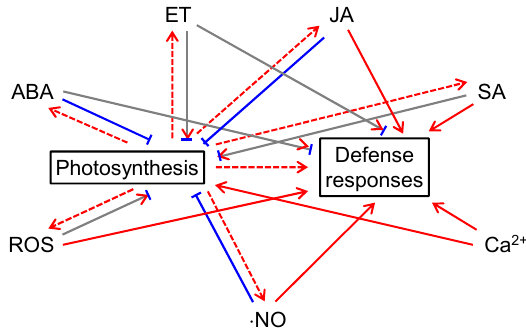
Figure 2. Interactions of photosynthesis and defense responses with defense–related signals. Red dotted arrows represent that photosynthesis provides electrons, NADPH, ATP, and/or carbon skeletons to the biosynthesis of defense hormones and other signals. Red arrow heads represent positive (promoting) effects; blue bars represent negative (inhibitory) effects; grey lines with red arrow heads and blue bars represent both positive and negative effects.